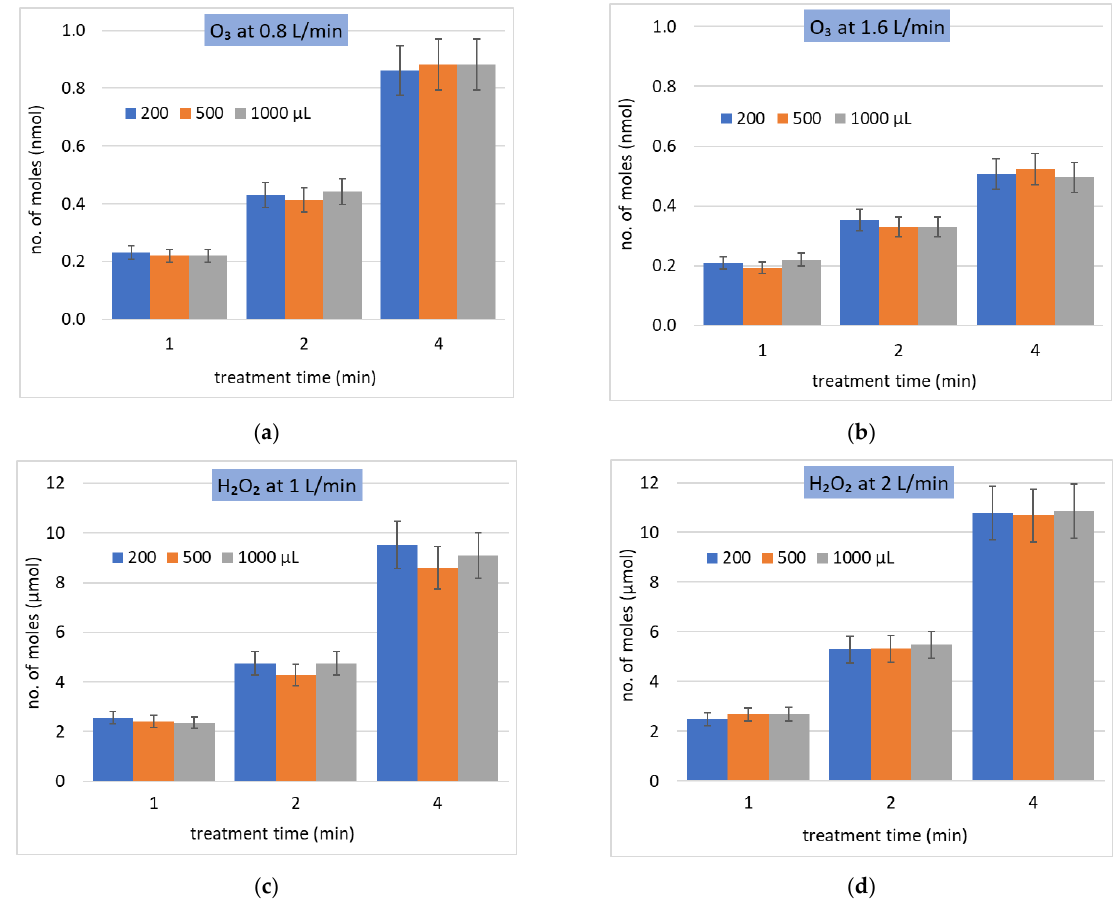
Figure 3. Solvation of ( a , b ) O 3 and ( c , d ) H 2 O 2 at different gas flow rates (L/min) and water volumes ( µ L) during different treatment times (min) in bulk water. Total molar number of dissolved molecules as a function of treatment time, different water volumes, at constant gas–liquid interface